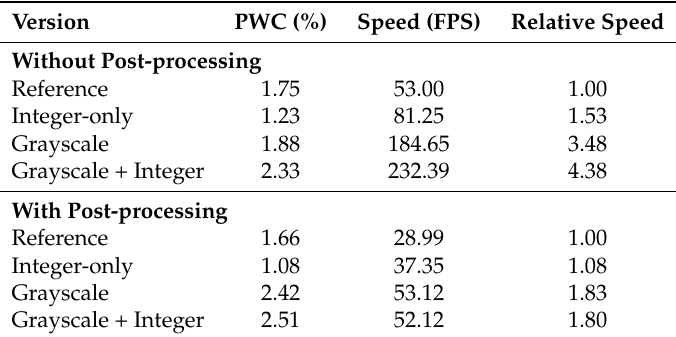
Table 1. Software Acceleration